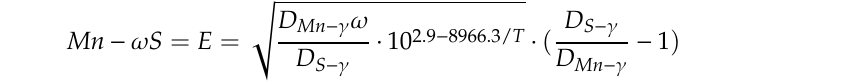
Table 4. Controlling element calculation of MnS in non-oriented electrical steel. Computational